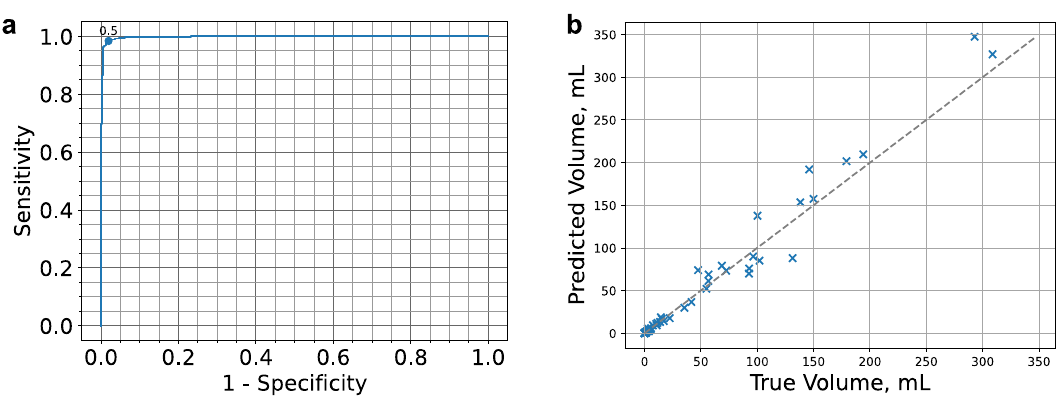
Figure 2. Model performance on primary test set: ( a ) Receiver operating characteristic curve for the primary test set including operating point of 0.5. ( b ) Volume plot comparing true (radiologist annotated) with predicted (model output) volumes for the primary test